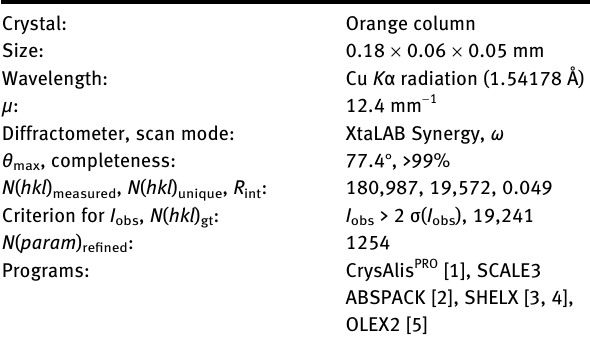
Table  : Fractional atomic coordinates and isotropic or equivalent isotropic displacement parameters (Å 